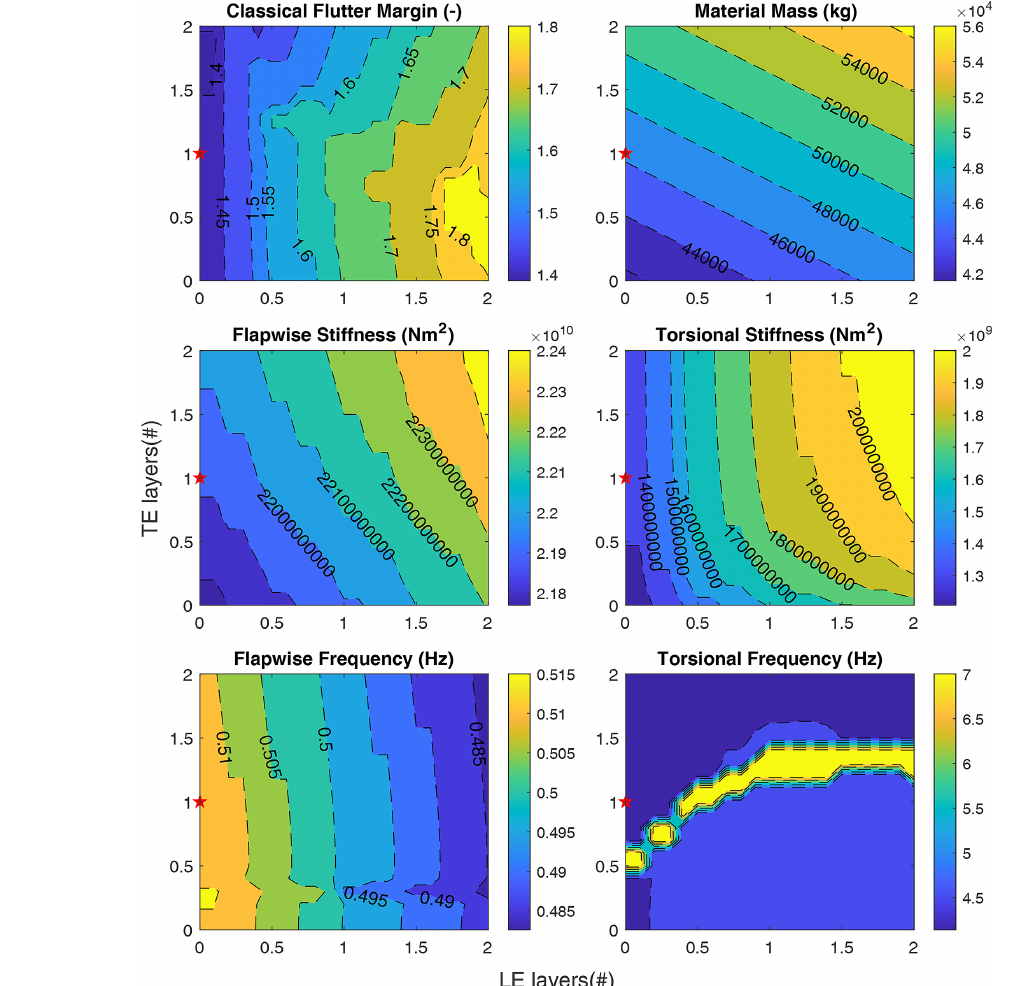
Figure 11. LE and TE sweep for the three-bladed SNL100-03 blade. The red star in the plots indicates the baseline blade design (SNL100-